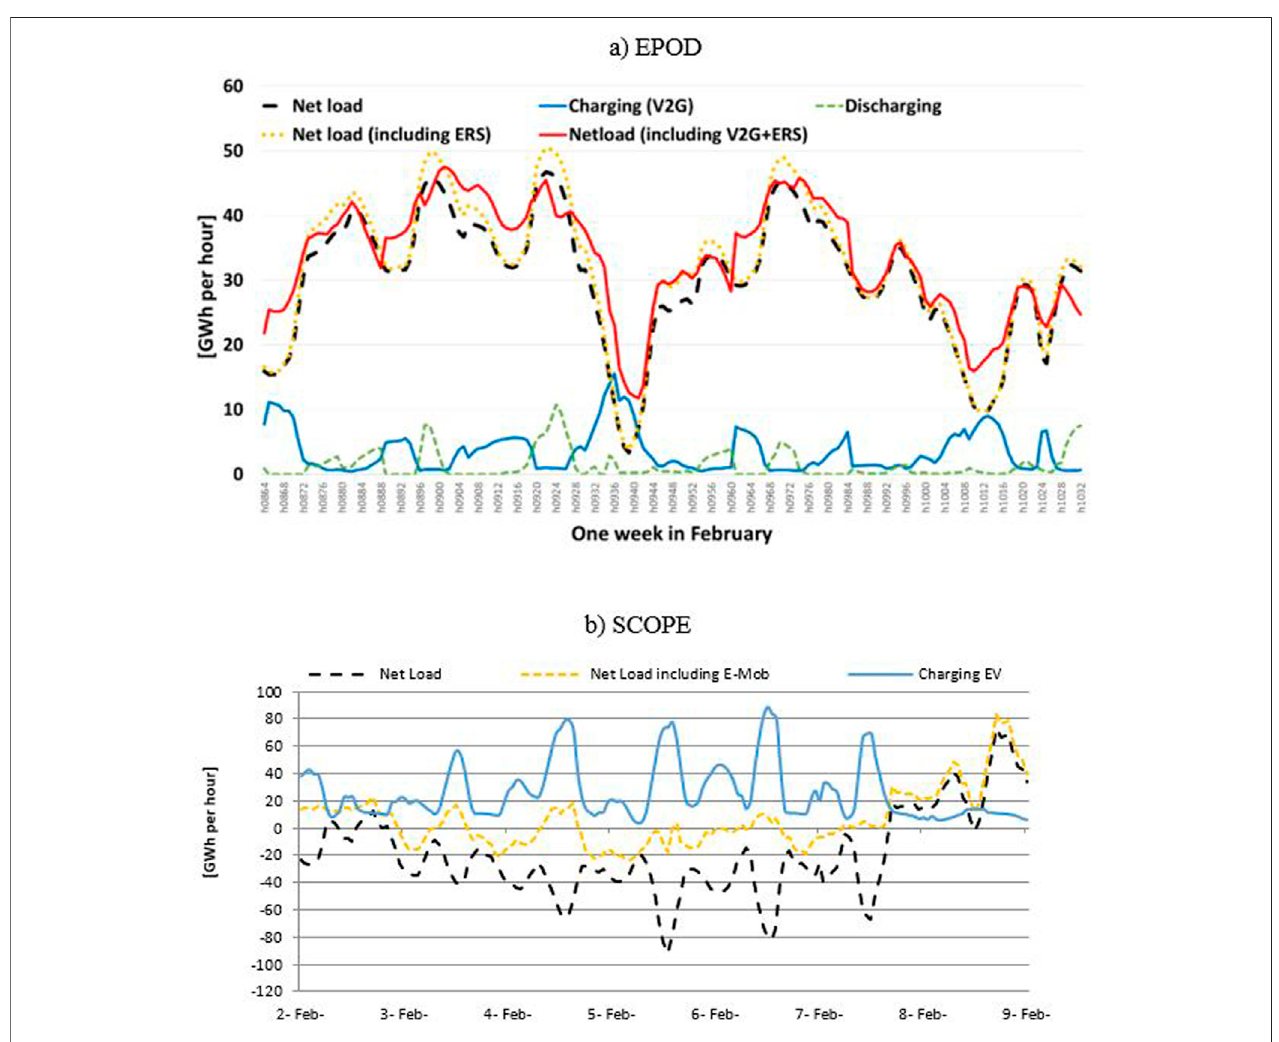
FIGURE 7 | Net load for one week in February in Germany assuming a number of separate model runs, including and excluding electric road systems (ERS) for trucks and buses, and the load from charging passenger EVs and V2G in the (A) EPOD and (B) SCOPE. SCOPE also includes hourly production of PtG.